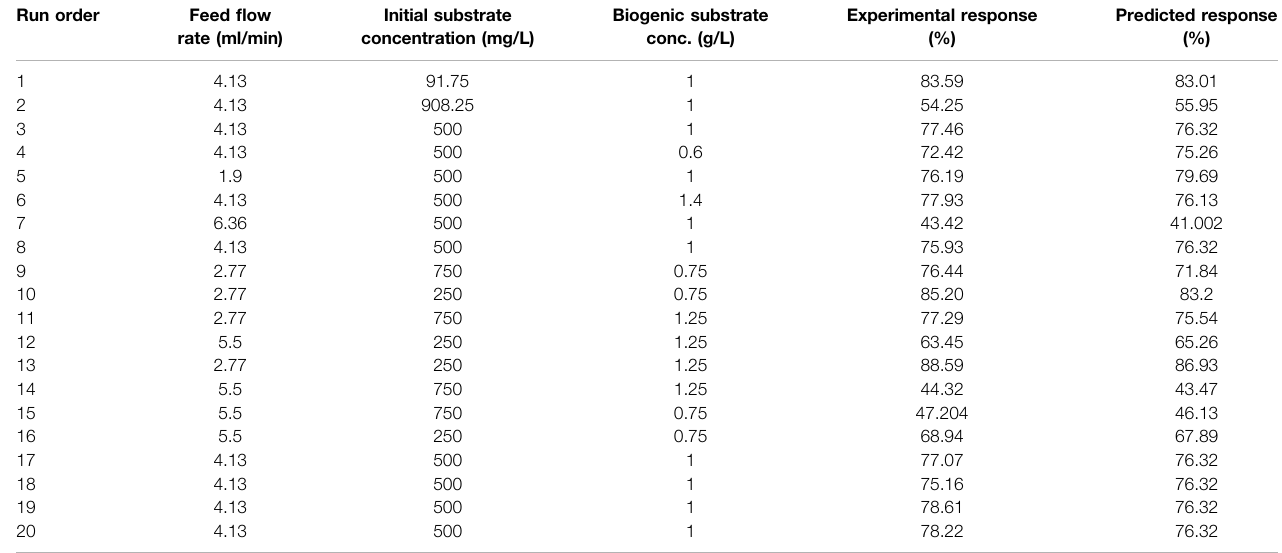
Biogenic substrate conc.